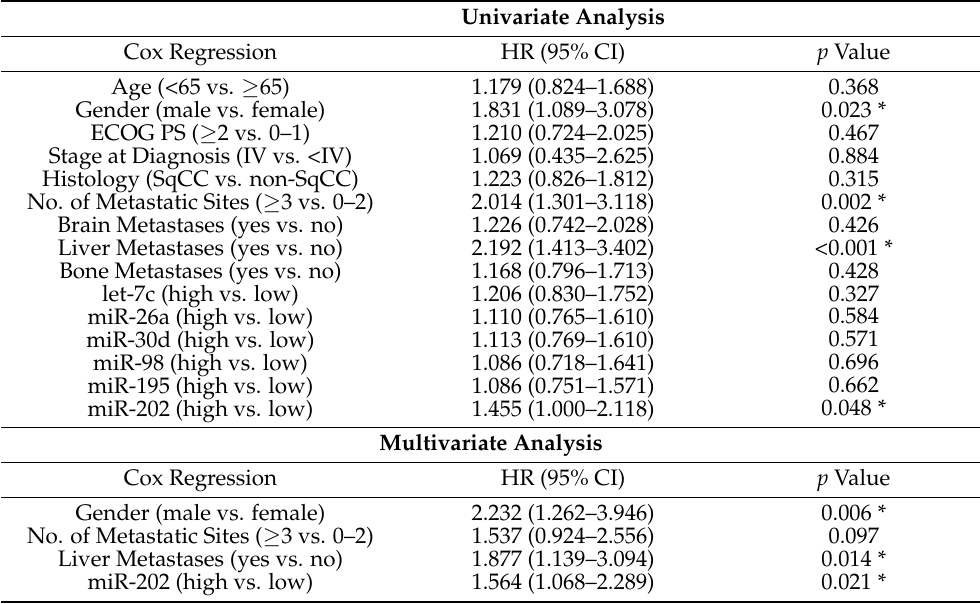
Table 3. Univariate and multivariate Cox regression analysis for progression-free survival (PFS) in NSCLC patients (N = 125).